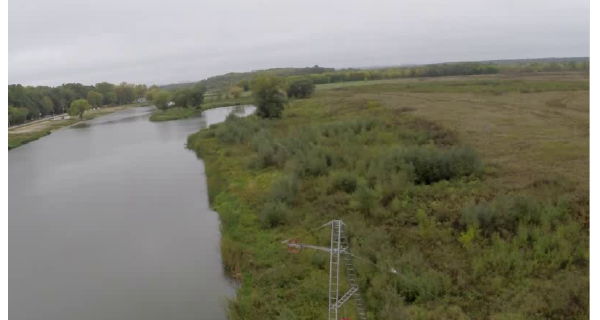
Figure 1: Original image